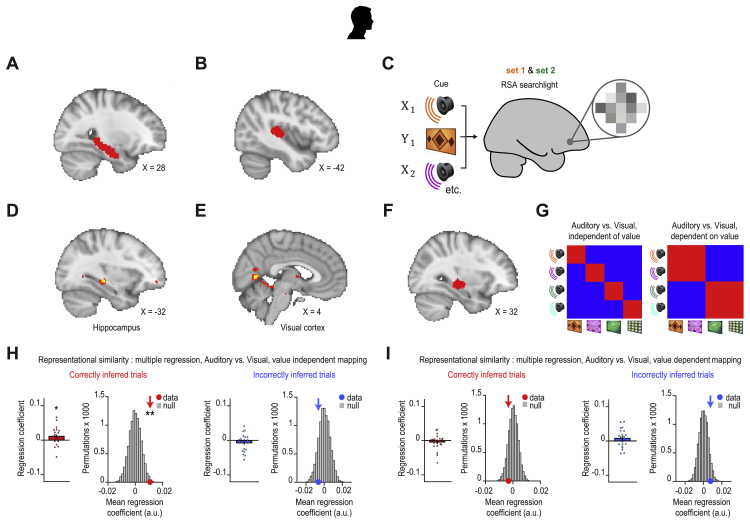
Regions of Interest and RSA during the Inference Test in Humans, Related to Figures 2 and 4In humans: (A) An anatomical ROI in the hippocampus. This ROI was used to correct for multiple comparisons across the hippocampal volume (Figure 2B). (B) An ROI in auditory cortex was defined from a contrast comparing BOLD signal during inference test trials to conditioning trials (Figure 2C). This ROI was then used as a seed region for a Psychological-Physiological Interaction analysis which identified brain regions that differentially co-activate with auditory cortex across correct and incorrect trials in the inference test (Figure 2D). (C) During correctly inferred trials in the inference test, searchlight RSA was applied to fMRI data in humans to identify brain regions showing representational similarity between auditory cues Xn and visual cues Yn. A model representational similarity matrix (Figure 4E) that mapped the auditory-to-visual associations learned during the inference task was compared with the activity patterns across voxels extracted from each searchlight, using a summary statistic estimated as follows: [average within association XnYn correlations from RSM main diagonal] – [average between association XnYm correlations from RSM off-diagonals]. (D) The searchlight analysis described in (C) revealed significant auditory-visual mappings in the hippocampus (t21 = 4.76, p = 0.025; peak-level FWE corrected using small-volume correction method), as observed in Figure 4. (E) The searchlight analysis described in (C) further revealed significant auditory-visual mappings in the visual cortex (t21 = 4.94, p = 0.012, FWE whole-brain corrected at the cluster-level). T-statistic maps are thresholded at p < 0.01 uncorrected for visualization purposes only. (F) In humans, RSA was applied to BOLD signal extracted from a region of interest (ROI) in the hippocampus, defined from the univariate contrast reported in Figure 2B, thresholded at p < 0.01 uncorrected. (G) Applying RSA to hippocampal activity we modeled the mappings from Xn in the inference test to Yn in conditioning, both independent of the value of the associated Zn (left), and dependent upon the value of the associated Zn (right). We then used multiple regression to regress the data onto these two models, to assess evidence for prospective representation of visual cues Yn over and above representation of the value associated with the visual cues. (H) Using multiple regression described in G, during correct inference, activity patterns in the hippocampus significantly predicted mappings from Xn to Yn, independent of the value of the associated Zn cues (correct and incorrect inference: Z21 = 2.01, p = 0.022 and Z21 = −1.07, p = 0.858; mean ± SEM). The group mean was further compared against a null distribution generated by permuting the identity labels assigned to the auditory cues Xn (correct and incorrect inference: p = 0.006 and p = 0.854). (I) Using multiple regression described in G, during correct inference, activity patterns in the hippocampus did not significantly predict mappings from Xn to Yn, dependent upon the value of the associated Zn cues (correct and incorrect inference: Z21 = −0.39, p = 0.652 and Z21 = 1.23, p = 0.109; mean ± SEM). The group mean was further compared against a null distribution generated by permuting the identity labels assigned to the auditory cues Xn (correct and incorrect inference: p = 0.839 and p = 0.070). Thus, during inferential choice hippocampal activity in humans prospectively represents visual cues Yn over and above representation of the value of the associated Zn cues.